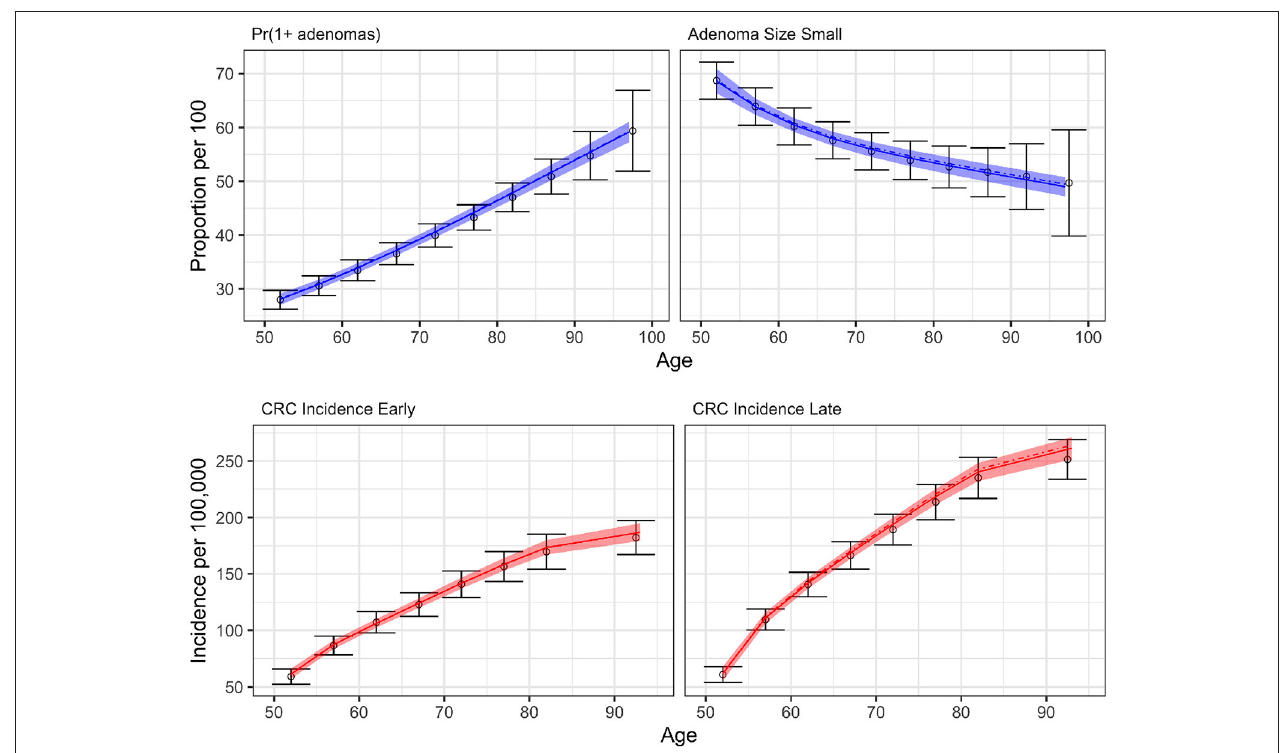
FIGURE 6 | BayCANN calibration results by age in years on the x-axis. The upper panels show adenoma targets and lower panels show cancer incidence targets by stage. Calibration targets with their 95% confidence intervals are shown in black. The colored curves show the posterior model-predicted mean, and the shaded area shows the corresponding 95% posterior model-predicted credible interval of the outcomes. The dashed-dotted lines represent the output using the maximum a posteriori (MAP) estimate from